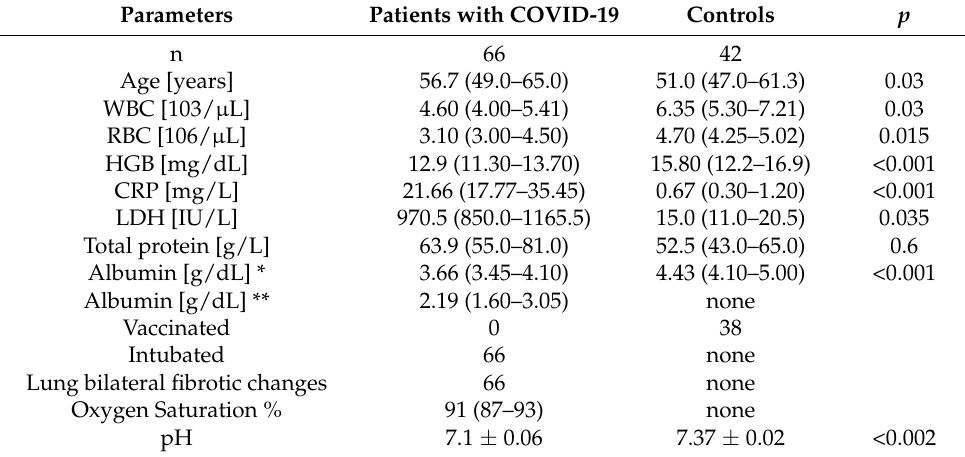
Table 1. Demographic and clinical data on Hgb, CRP, and LDH levels; vaccination status in patients with COVID-19 and healthy volunteers. The results are presented as mean ± SE: serum albumin level 48 h before becoming in the wrong condition (*); serum albumin level 24–48 h before exitus (**). Parameters Patients with COVID-19 Controls p n 66 42 Age